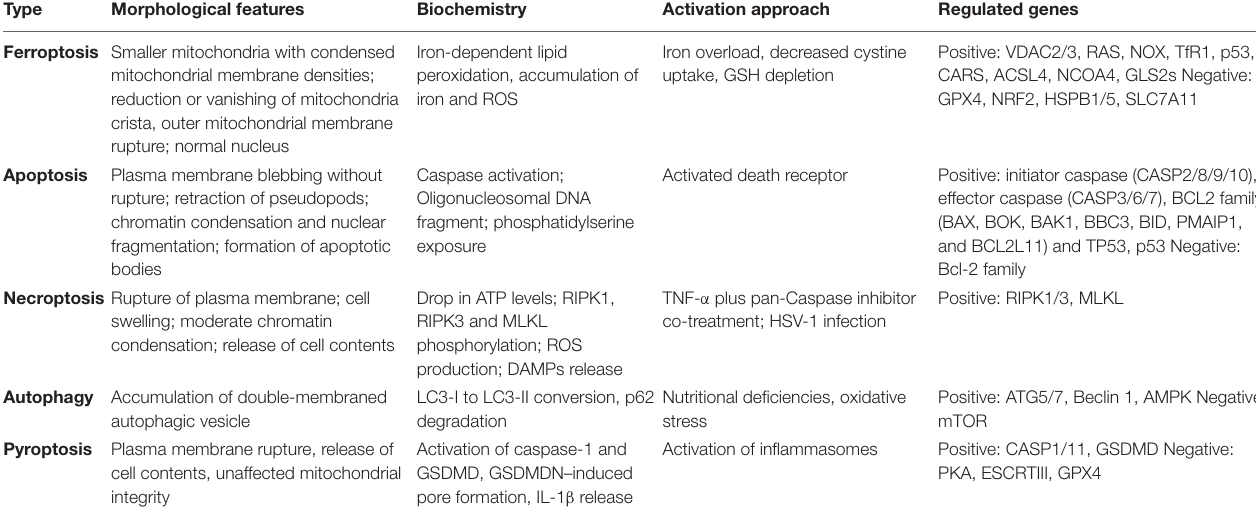
TABLE 1 | Characteristics of different types of regulated cell death.